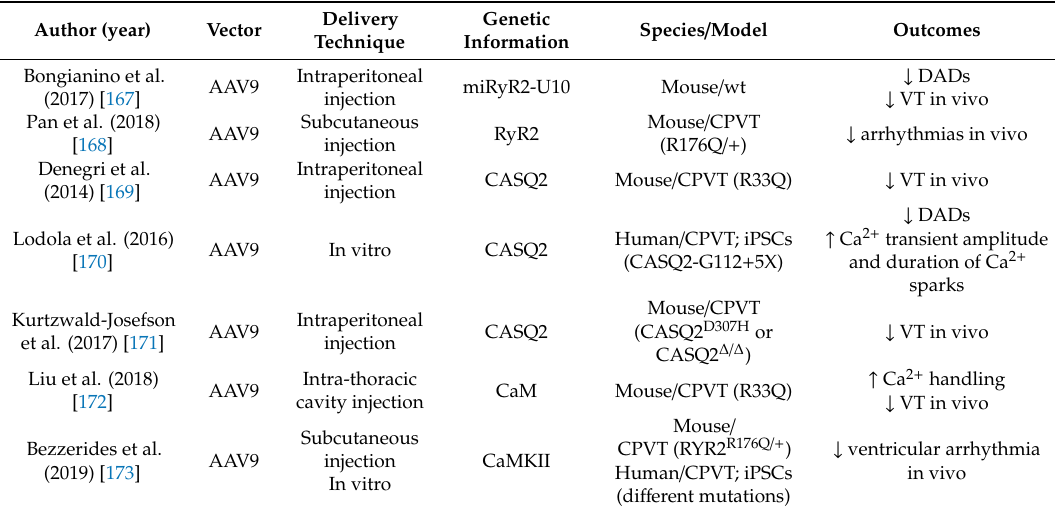
Table 4. Gene therapies for ventricular tachycardia targeting ryanodine receptor 2 (RyR2) and genes of RyR2-mediating